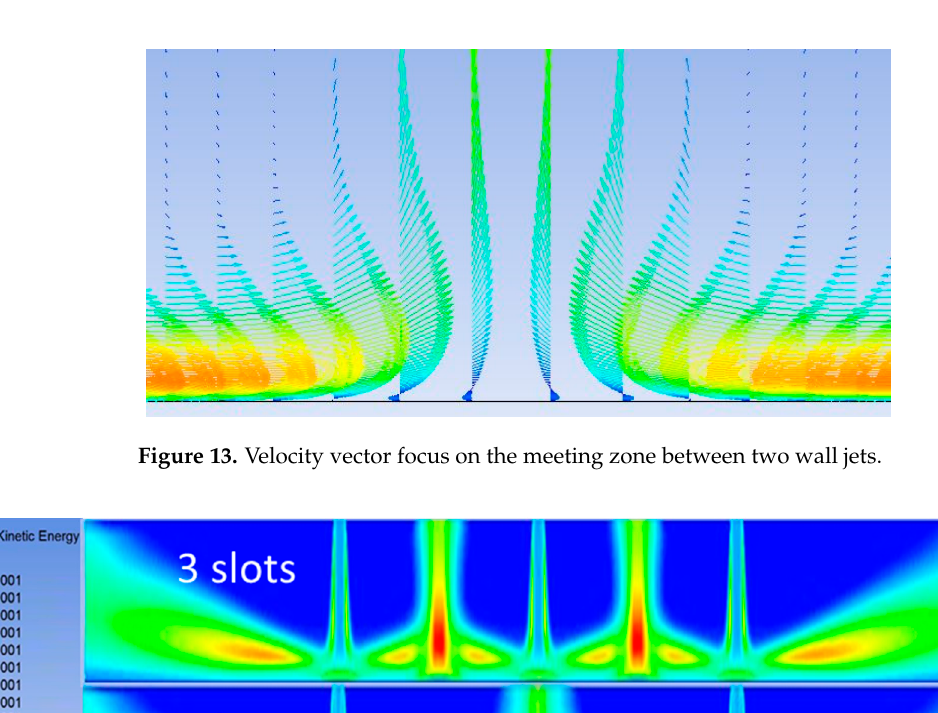
Figure 12. Pressure contours and surface streamlines of multi slot jet configuration with H/B = 4, Re = 5500 and realizable